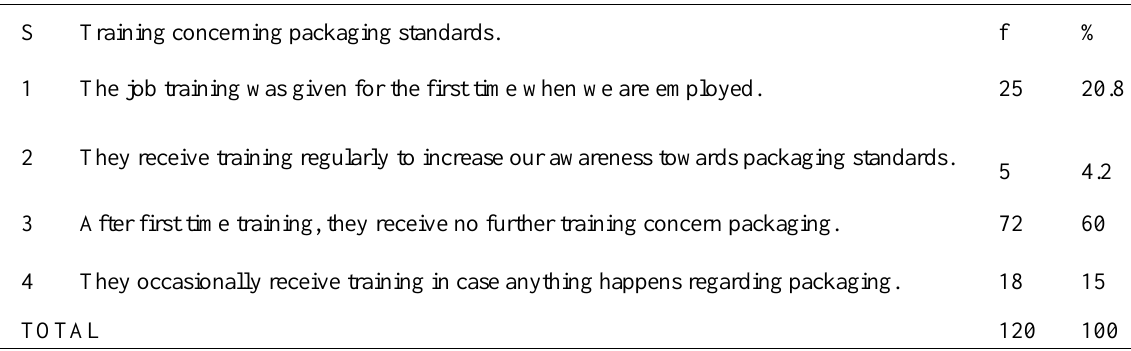
Table 2. The response towards packaging